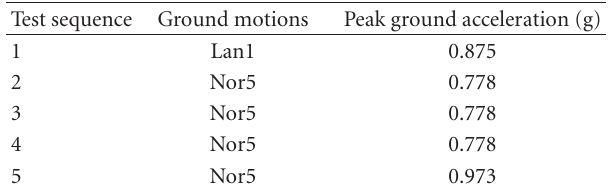
Figure 8: Formwork before pouring of concrete. Table 7: Test sequence.